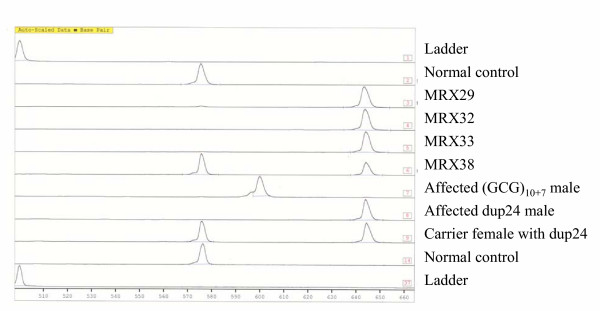
Chromatograph of samples with ARX 24dup mutation. Lane 17 is the 50–500 bp ladder lanes. Lane 14 is a normal control. Lane 3 is an affected male from MRX29. Lane 4 is an affected male from MRX32. Lane 5 is an affected male from MRX33. Lane 6 is a female carrier from MRX38. Lane 7 is a male with (GCG)10+7 ARX mutation. Lane 8 is an affected male with a known dup24 mutation and Lane 9 is a female carrier with the dup24 mutation.